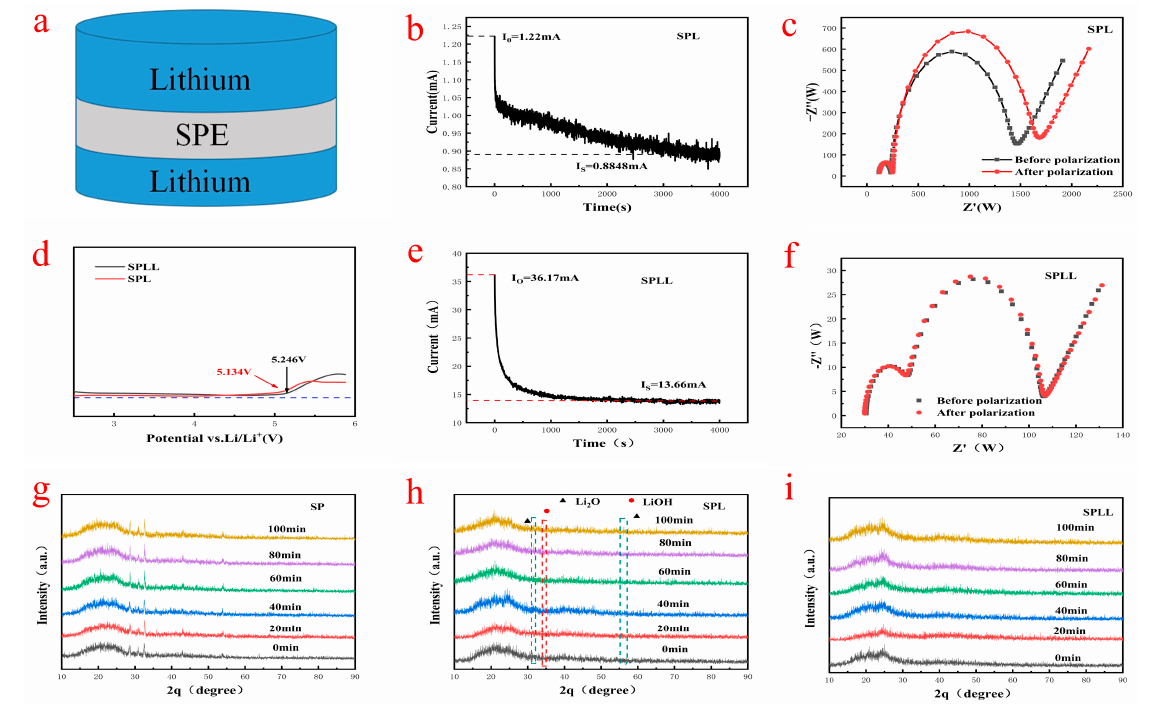
Figure 4. ( a ) Polymer electrolyte membrane assembly test. ( b , c ) SPL timing current and impedance before and after timing. ( d ) SPL and SPLL linear voltammetry test. ( e , f ) SPLL timing current and impedance before and after timing. ( g – i ) XRD patterns after exposing to air (40% relative humidity).